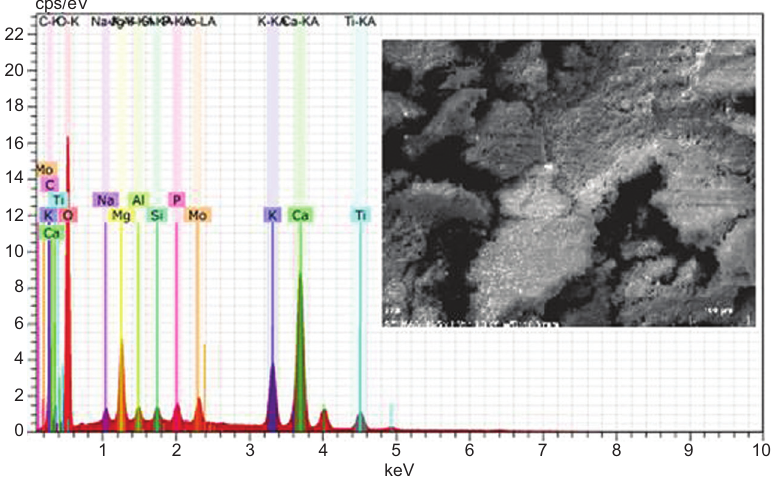
Figure 1 Elemental analysis and scanning electron microscopy images of reed chip ash.